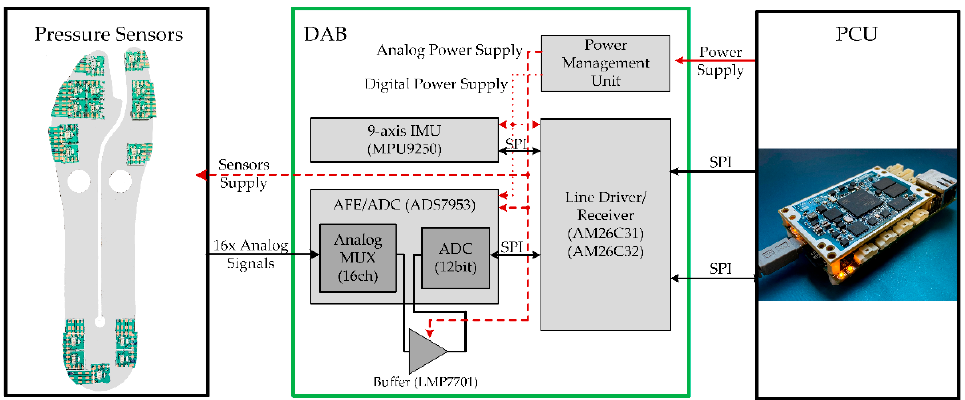
Figure 4. From left to right: pressure sensors arrangement below the prosthetic foot; Data Acquisition Board (DAB) architecture; Prosthesis Control Unit (PCU) for signal processing. The scheme of DAB comprises the IMU, the analog front end/ADC, the power management unit, and the differential line drivers.